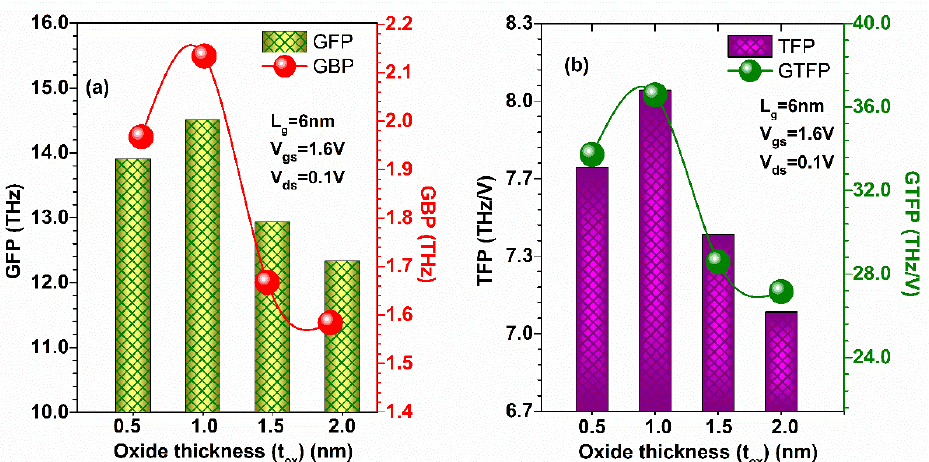
Figure 19. ( a ) GFP and GBP at various oxide thicknesses of GaN-SOI-FinFET. ( b ) TFP and GTFP at various oxide thicknesses of GaN-SOI-FinFET.